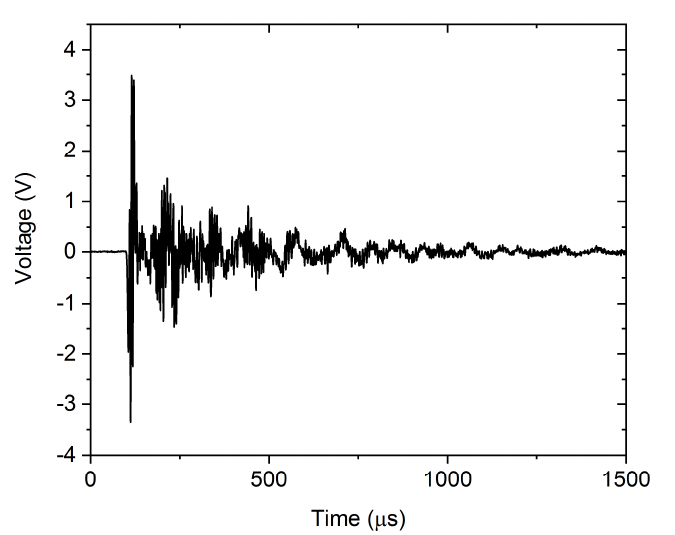
Figure 8. Characteristic avalanche of Cluster 5 at room temperature. The high-frequency ringing is visible, together with slower oscillations around 150 kHz, predicted by the PSD curve of Cluster 5 in Figure